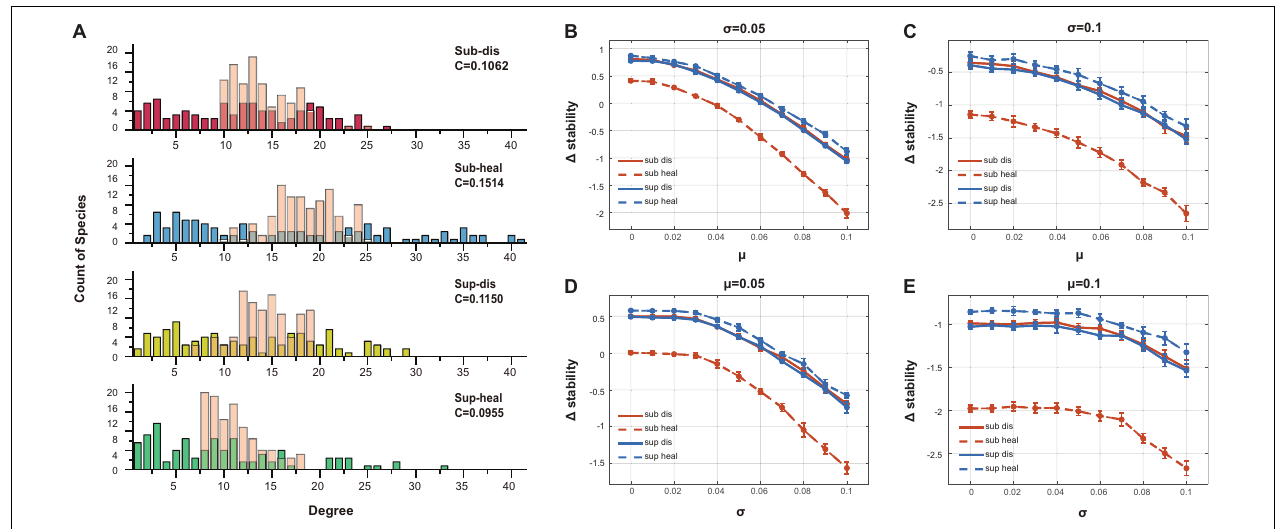
FIGURE 6 | Evaluation of the association between degree distribution and local stability. (A) The transparent pink bars showed the degree distribution of the ER networks while the opaque-colored bars showed the degree distribution of the original networks. The major difference was that the ER networks had concentrated degree distributions. (B)–(E) The vertical axis showed the stability change after ER randomization ( (cid:49) stability ). (cid:49) stability = sta origin − sta ER , in which sta origin was the stability of the original communities, while sta ER was the stability of the ER networks. It was clear that all original communities were less stable than their ER counterparts in all parameter sets (different µ and σ as in Figure 5 ), which indicated that their network structure tended to be destabilizing. The extent of stability decrease in the healthy subgingival group was much more than the other three groups, which meant that the network structure of the healthy subgingival community hampered stability the